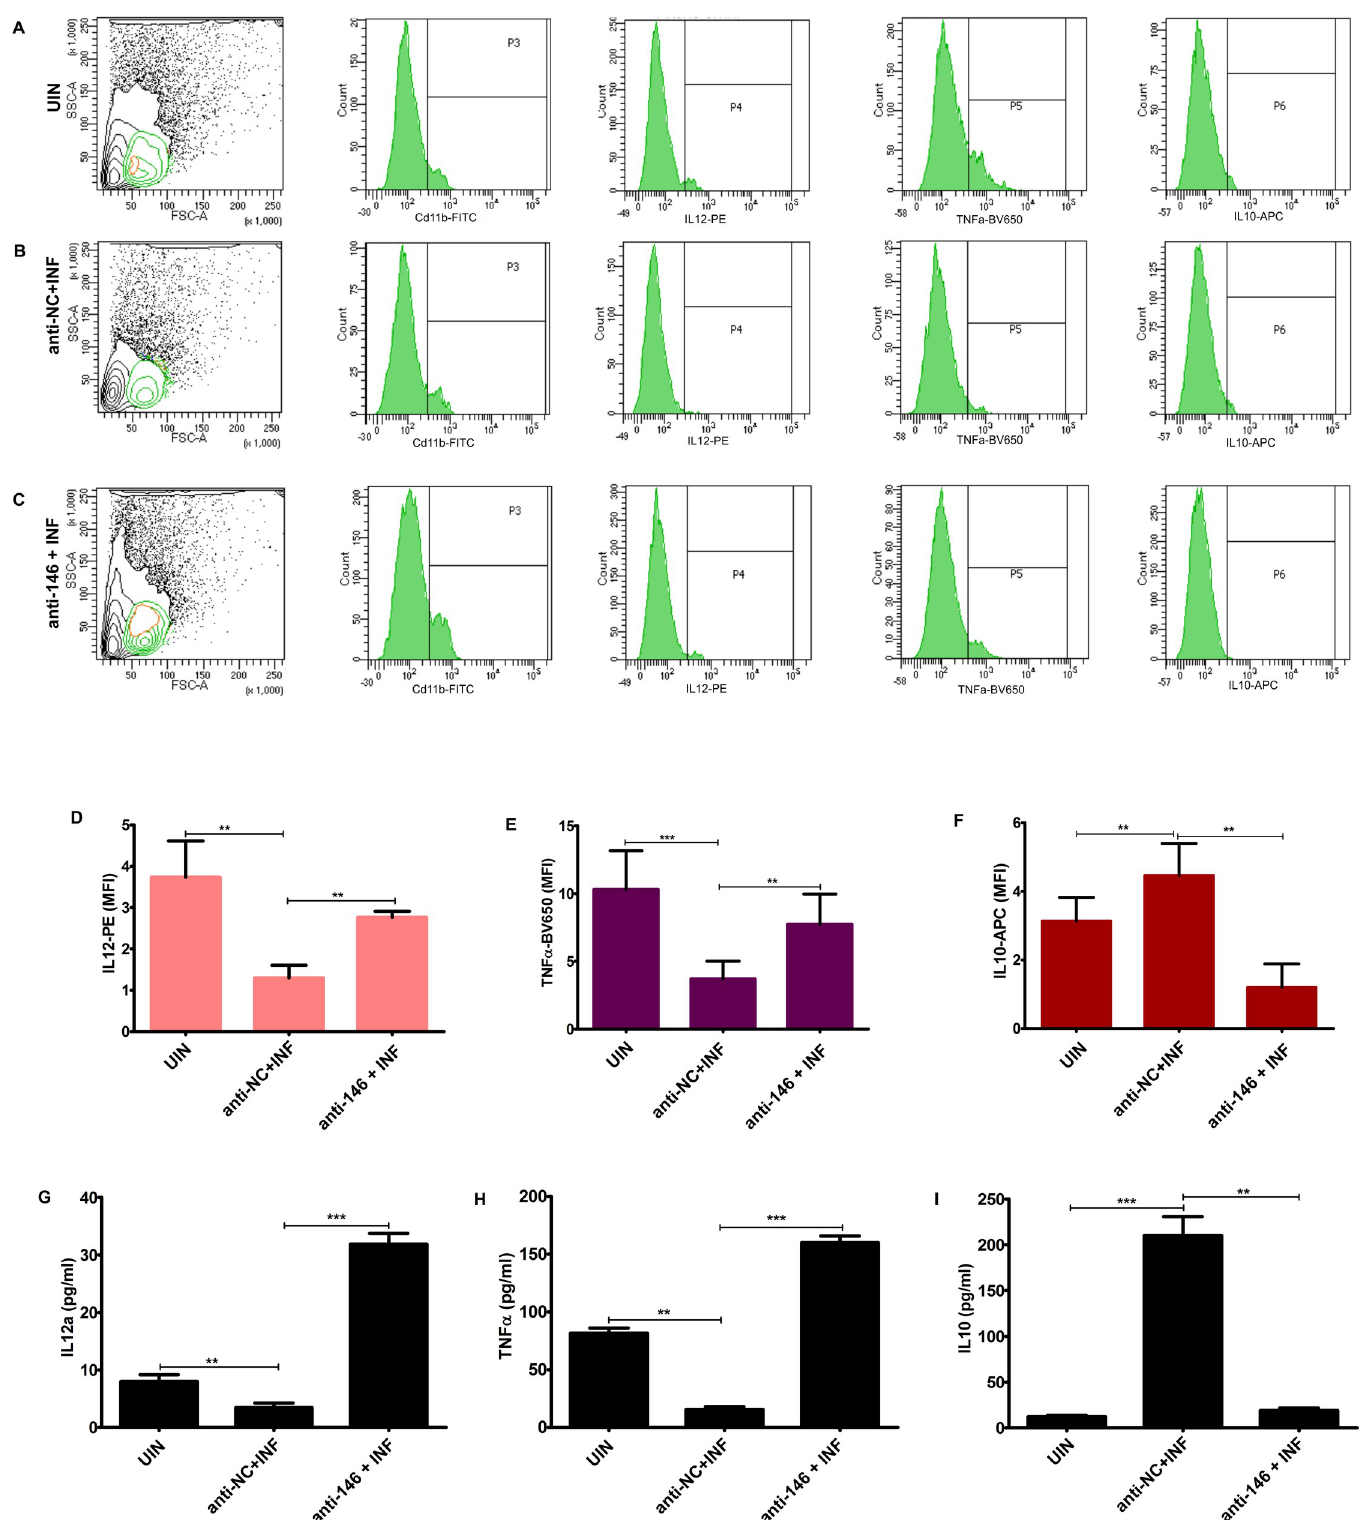
Fig 4. miR146a-5p is essential for L . donovani infection-mediated enrichment of anti-inflammatory M2 cytokines. BMDMs, transfected with anti-NC RNA and anti- miR146a-5p inhibitor oligos, were infected with L . donovani parasites for 24 hrs. (A-C) Cytokine expression profile was recorded from Cd11b + populations of